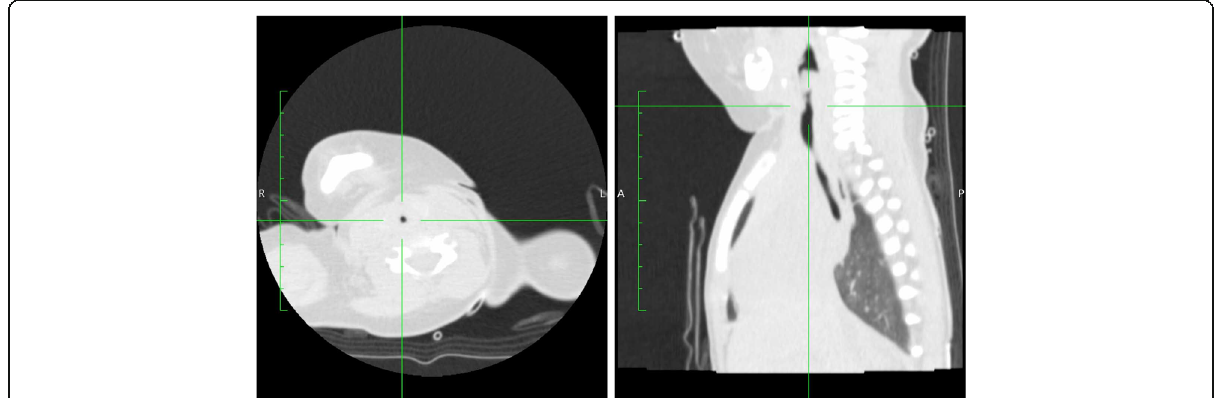
Fig. 2 Neck CT images taken at POD 2. Subglottic stenosis of the trachea was detected. Tracheal diameter at the narrowest level was calculated as 3.2 mm. Left , transverse image of the neck. Right , sagittal image of the